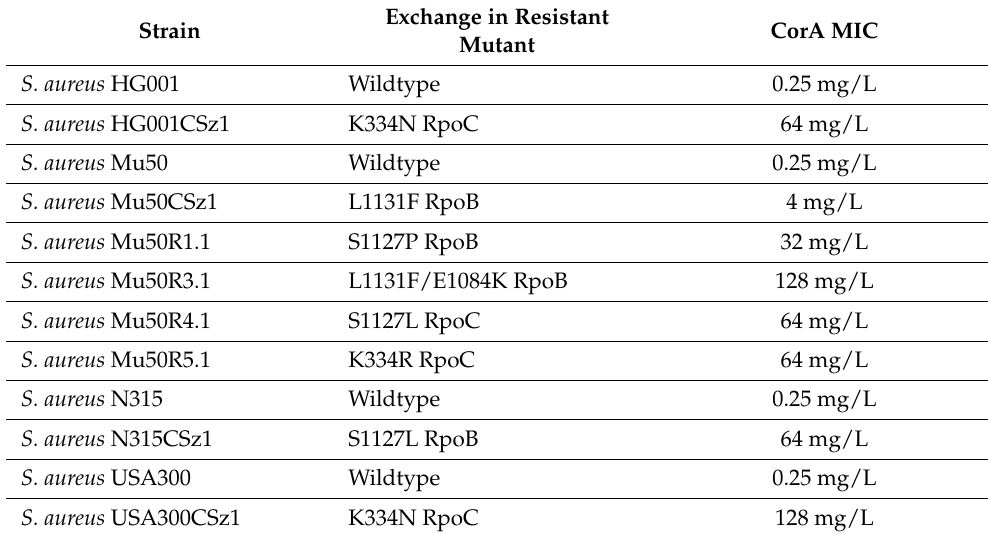
Table 1. CorA MICs for different S. aureus strains and their resistant mutants.